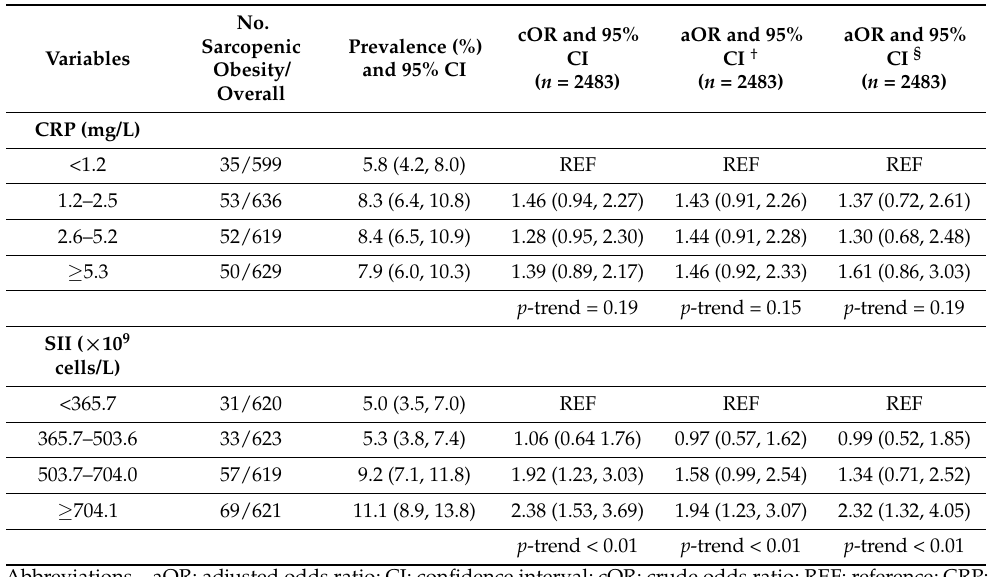
Table 4. Association between inflammatory biomarkers and sarcopenic obesity in older adults with chronic comorbidities, NHANES 1999-2006 (n =